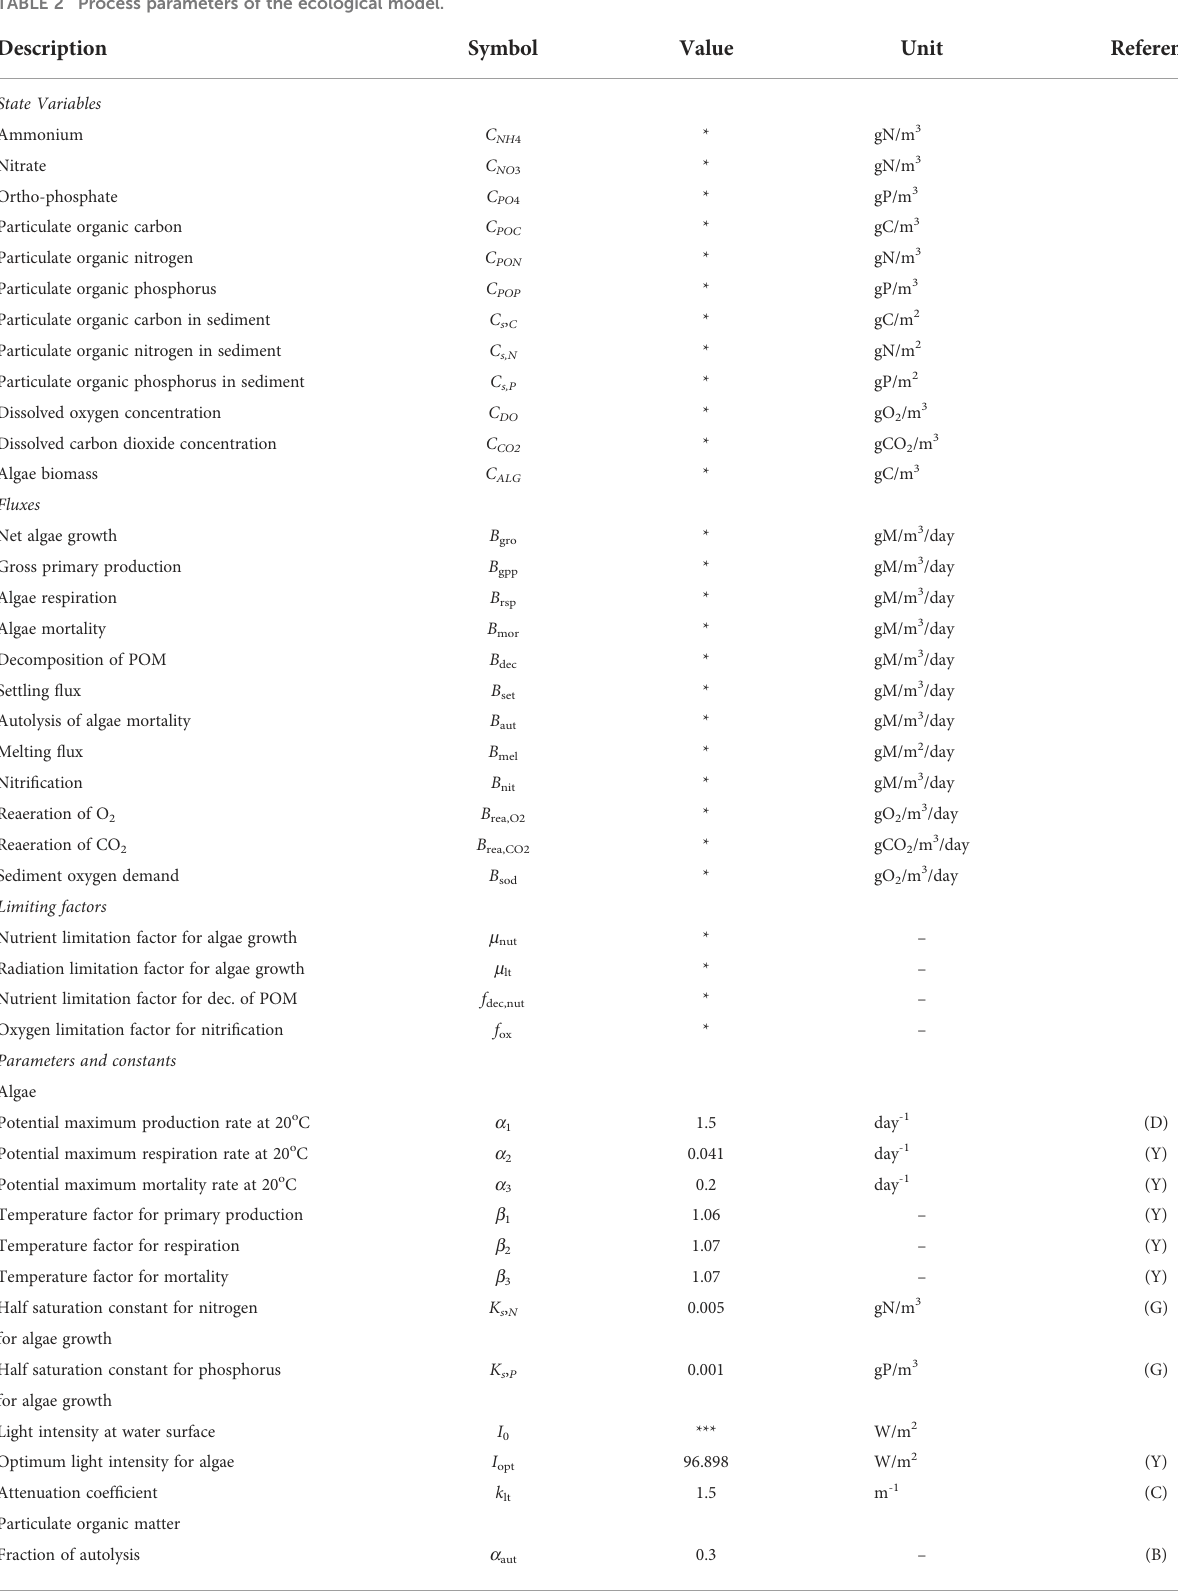
TABLE 2 Process parameters of the ecological